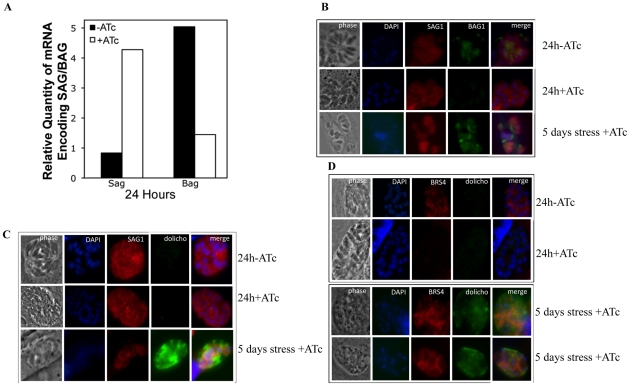
Message for SAG1 and BAG1 ±ATc for 4 or 24 hours of culture and immunofluorescence analyses for BAG1, SAG1, SRS9, and Dolichos.(A) Increased message for BAG1 and decreased message for SAG1 -ATc at 24 hours. There was no effect on BAG1 and SAG1 mRNA at 4 hours. These results were reproducible in two replicate experiments. WT =  wildtype strain. RPS13 =  conditional mutant. (B) To visualize the parasite cysts, Dolichos staining is green. Tachyzoite surface protein, SAG1 staining is red. The parasite and fibroblast nuclei stain blue. In either + or – ATc conditions, there is no Dolichos staining. In C, SAG1 staining is green, BAG1 staining is also green, DAPI is stained blue. -ATc BAG1 is present while +ATc BAG1 is absent. Control staining with 5 days of pH stress +ATc also is shown. (D) –Atc for 24 hours BRS4/SRS9 staining (red) is seen in some parasites but Dolichos staining is absent (top). Control staining of +ATc parasites that have been stressed with pH shock (bottom panel) show both green Dolichos staining and red BRS4/SRS9 staining, with dapi marking the parasite nuclei. –ATc parasite BAG1 transcript and protein increase. BRS4/SRS9 protein increases but Dolichos is not present in a cyst wall. These Δrps13 parasites when stressed with pH shock are capable of differentiating to parasites that form structures that stain with Dolichos as well as producing BAG1 and BRS4. -ATc, some Δrps13 parasites stain for BAG1 and SRS9, but not for Dolichos.